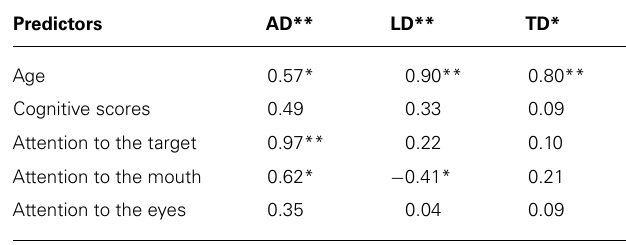
Table 3 | Linear regression beta weights and significance for Preschool Language Scale composite raw scores within groups factoring out cognitive scores and